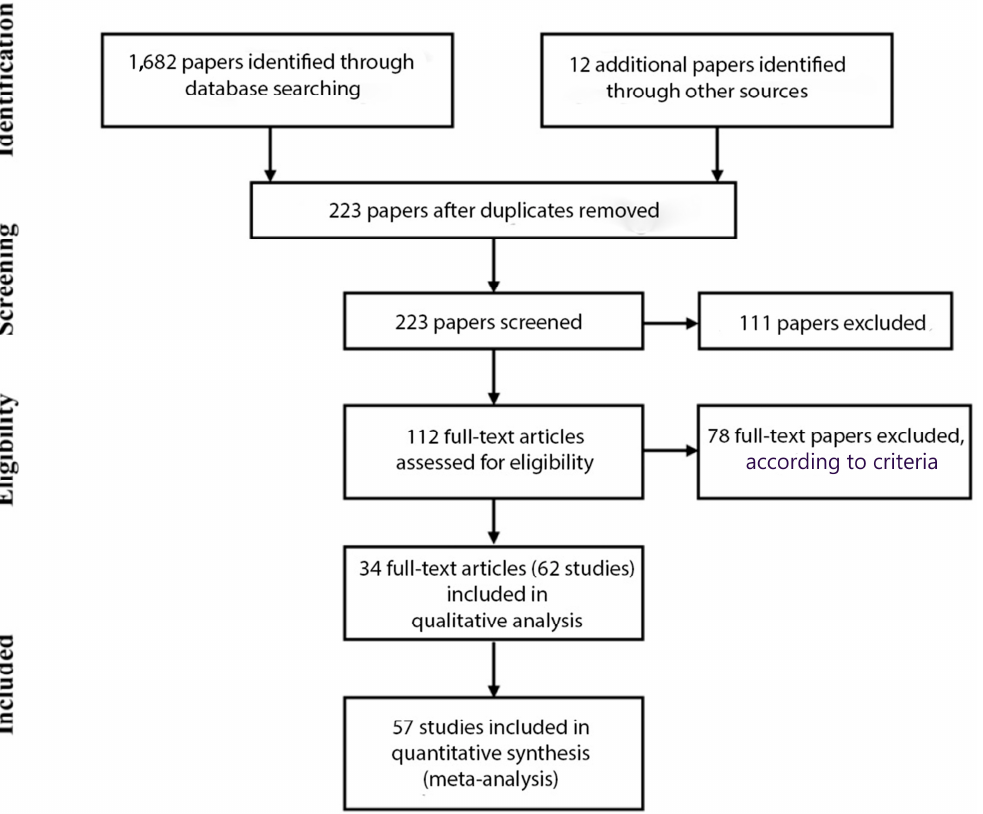
Figure 1. Flow ‐ chart of the study selection process (following the PRISMA flow ‐ chart, Moher et al. [14]). Figure 1. Flow-chart of the study selection process (following the PRISMA flow-chart, Moher et al. [14]). Selection criteria are explained in Supplementary Materials S3. Selection criteria are explained in Supplementary Materials